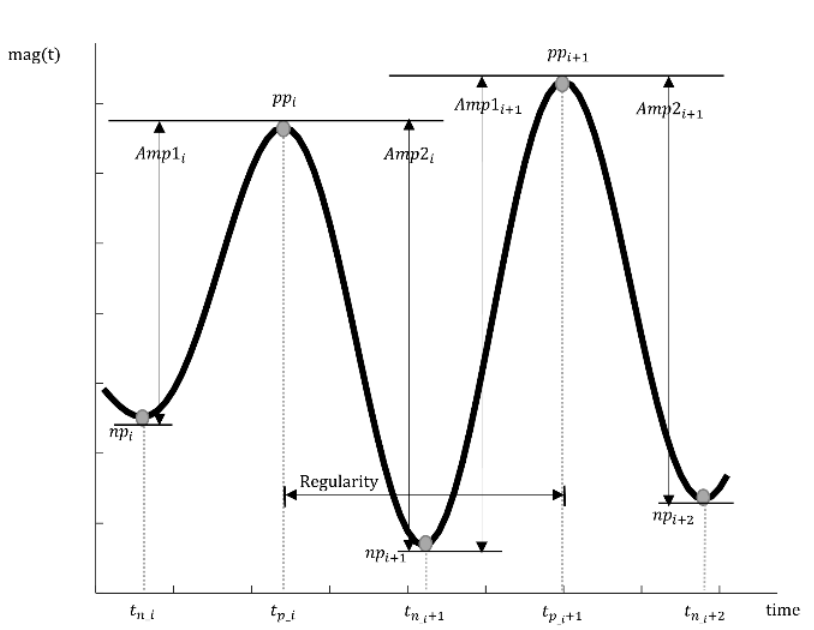
Figure 3. Graphically intuitive representation of temporal features. Two consecutive positive peaks (PP) and three consecutive negative peaks (NP) of the root mean square (RMS) signal of a tremor are shown together. The amplitude of each peak and the regularity are illustrated.